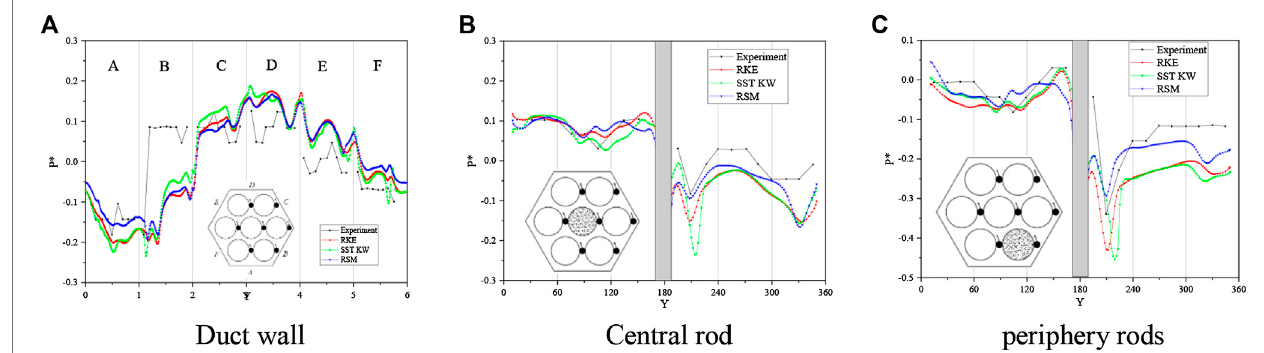
FIGURE 8 | Comparison of the pressure Distribution. (A) Duct wall. (B) Central rod. (C) periphery rods.